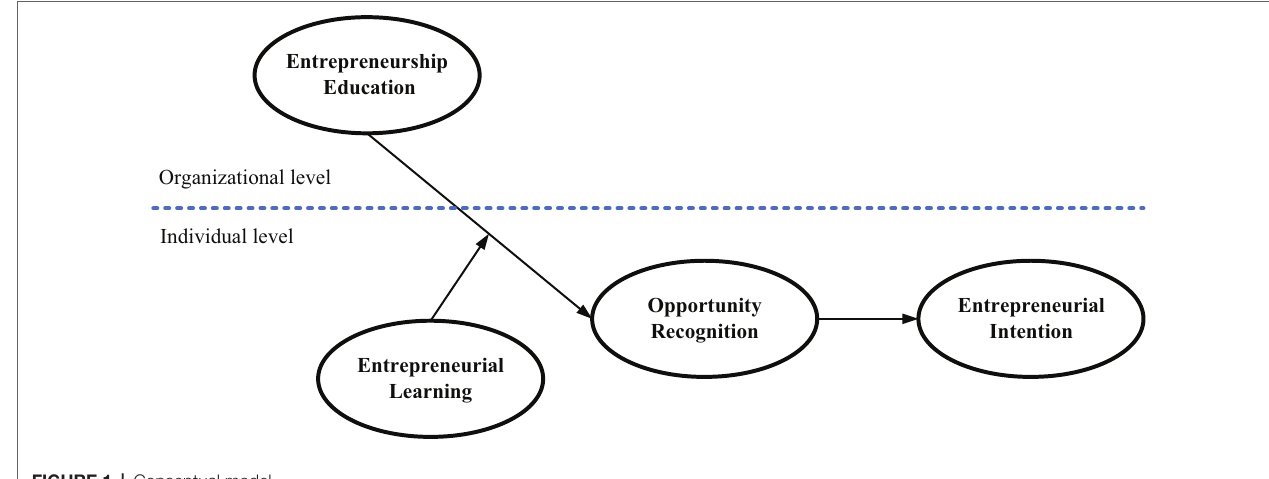
FIGURE 1 | Conceptual